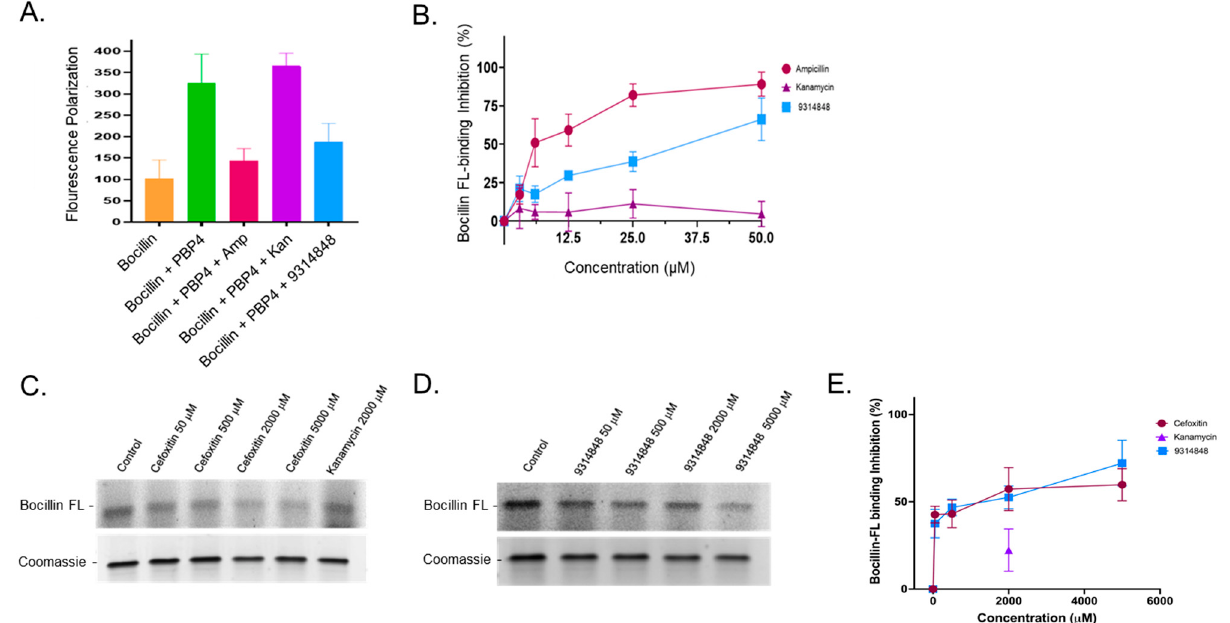
Figure 4. PBP4 binding assays. Panel ( A ). Fluorescence polarization of BOCILLIN FL (alone) and in the presence of Bacillus subtilis PBP4 following mock treatment or treatment with 50 µM of either ampicillin, kanamycin, or 9314848. Panel ( B ). Percent PBP4 BOCILLIN FL binding inhibition following pre-treatment with 0, 3.1, 6.2, 12.5, 25.0, or 50.0 µM ampicillin, kanamycin, or 9314848. Panel ( C ). Top —gel electrophoresis and fluorescent detection of BOCILLIN FL labeled PBP4 following treatment with 0 (control), 50, 500, 2000, or 5000 µM cefoxitin or 2000 µM kanamycin; Bottom —same gel Coomassie blue stained to control for loading. Panel ( D ). Top —gel electrophoresis and fluorescent detection of BOCILLIN FL labeled PBP4 following treatment with 0 (control), 50, 500, 2000, or 5000 µM 9314848; Bottom —same gel Coomassie blue stained. Panel ( E ). Graphed are the average gel-based BOCILLIN FL inhibition measures from 3 independent experiments; standard deviations shown.